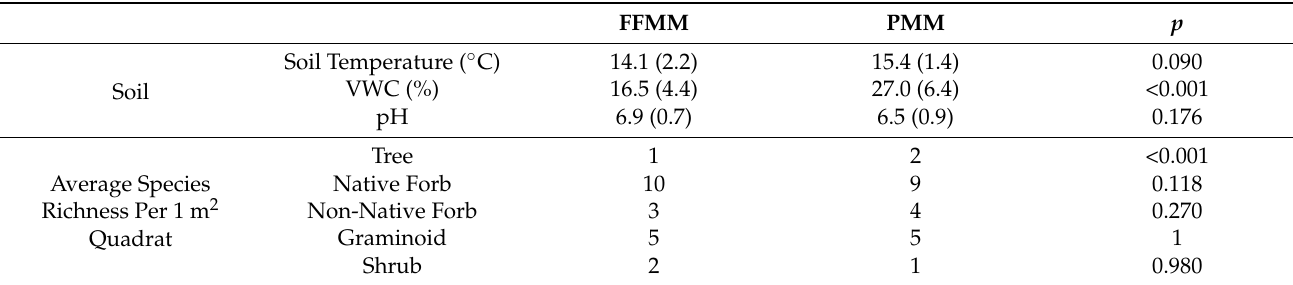
Table 1. Study site characteristics for showing average soil temperature, VWC, pH, (standard deviation), and species richness for both soil types (FFMM n = 20; PMM n = 20). p -values for soil temperature are based on ANOVA and all other p -values are based on